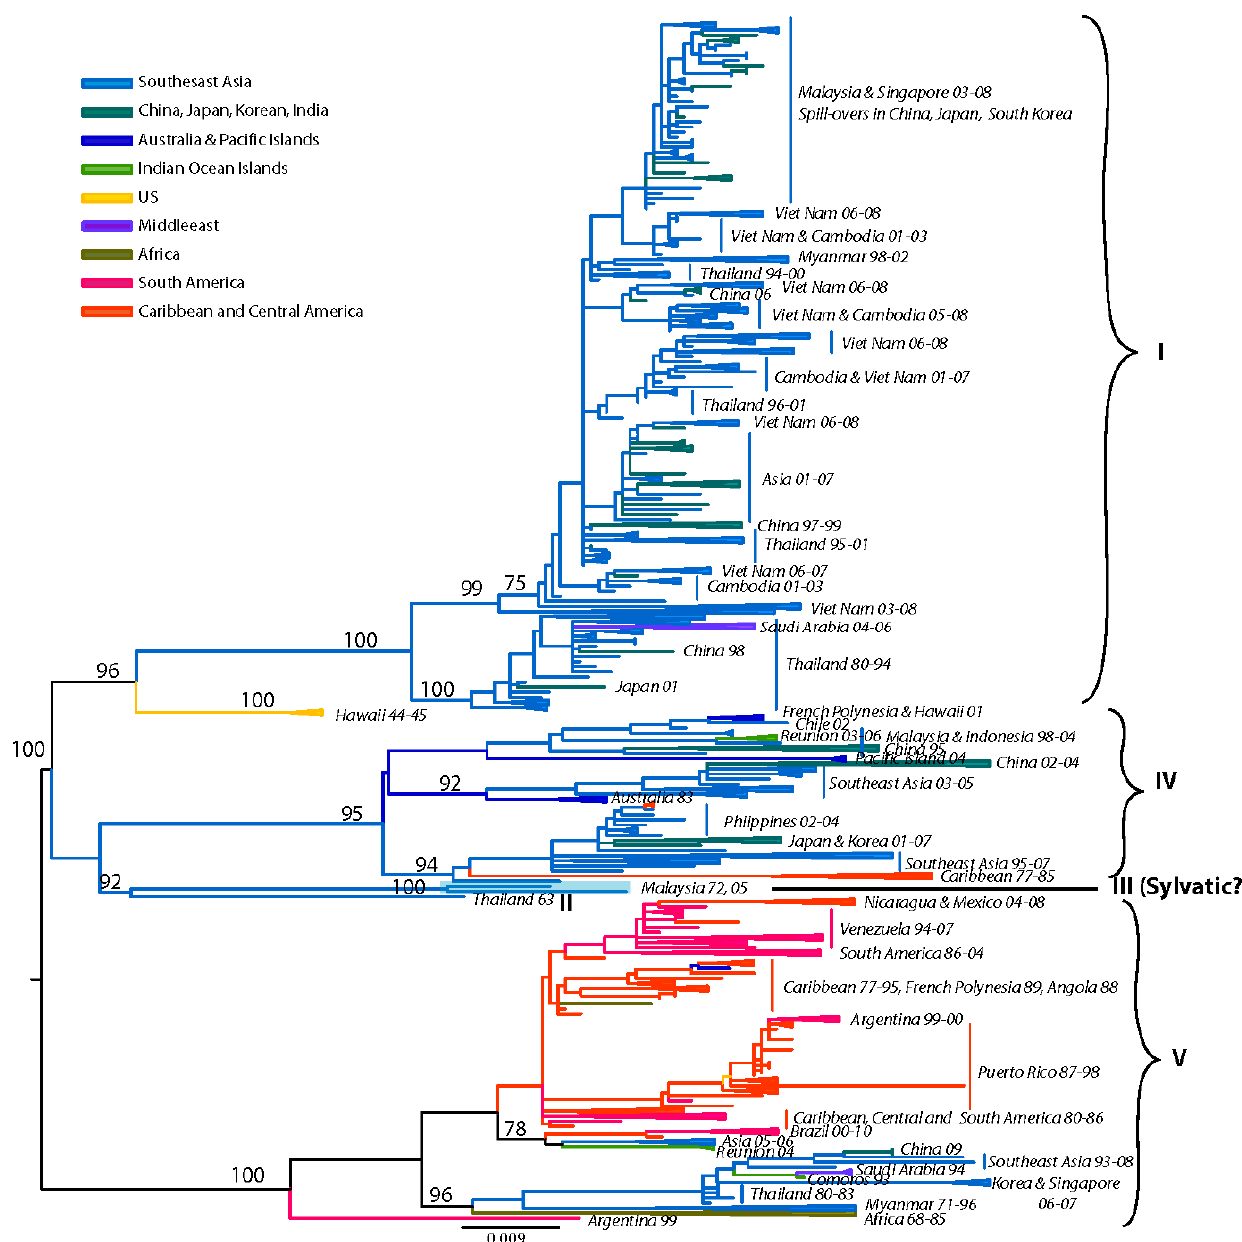
Figure 2. Dengue Virus Type 1 Phylogeny. Maximum Likelihood Tree (MLT) of